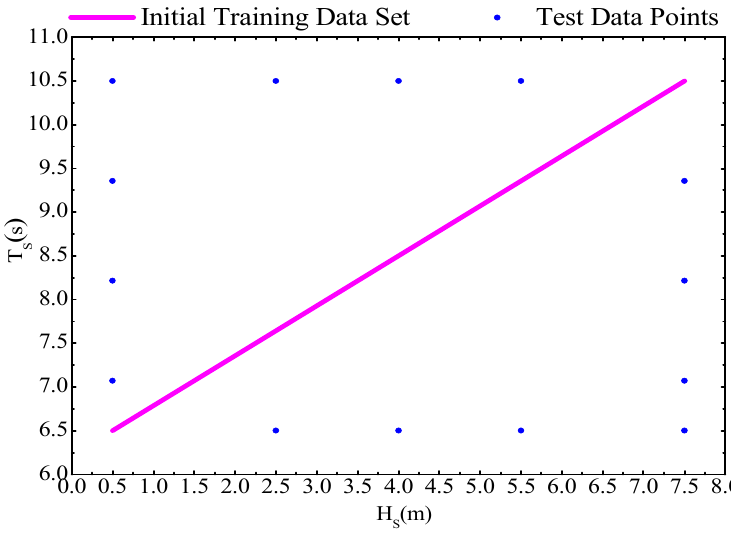
Figure 6. Distribution of test samples and the initial training set.